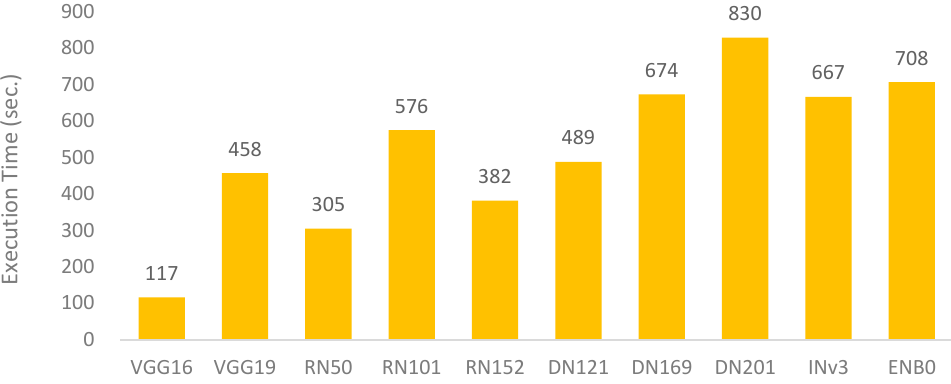
Figure 14. Training time of the recognition models.